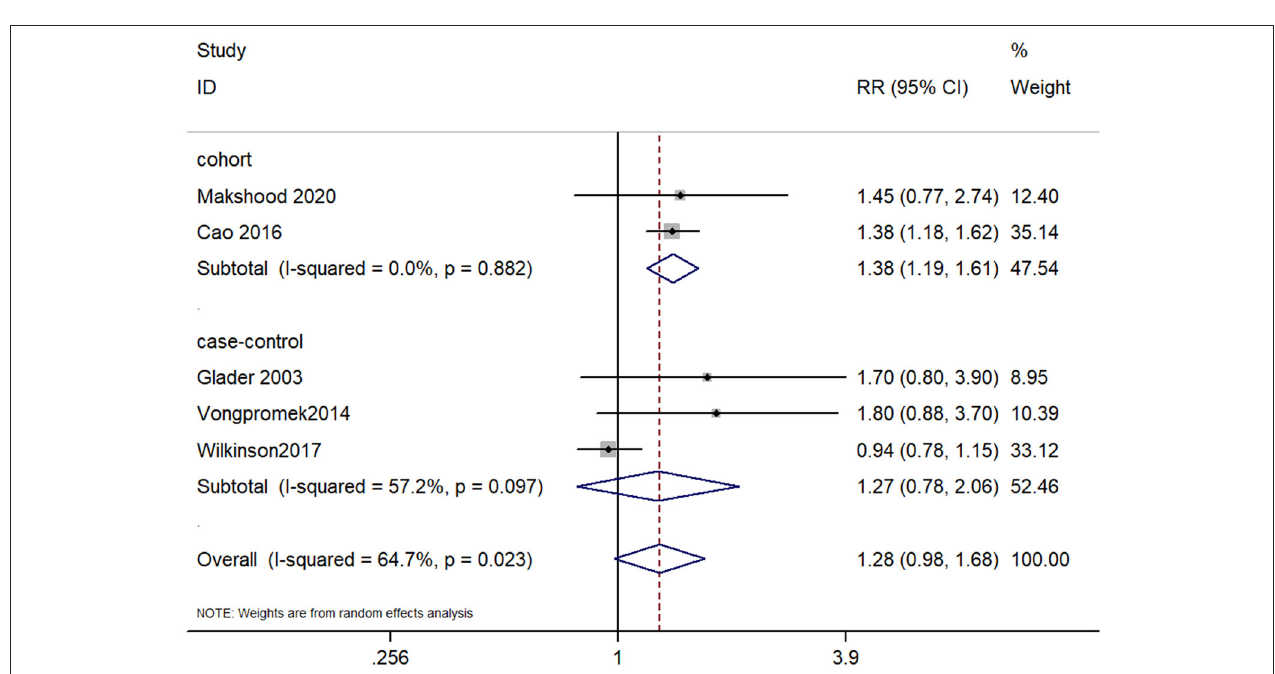
FIGURE 3 | Forest plot for examining the association between lp(a) ≤ 30 mg/dL and CAVD.